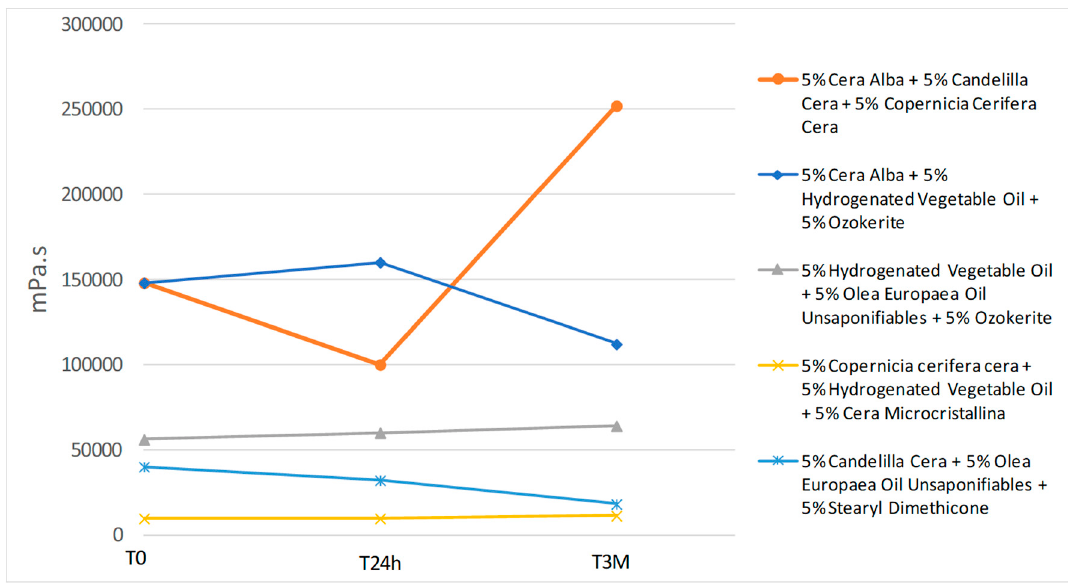
Figure 3. Trend of viscosity values at 2.5 rpm of blends waxes in oil at T 0 , T24 h, and after 3